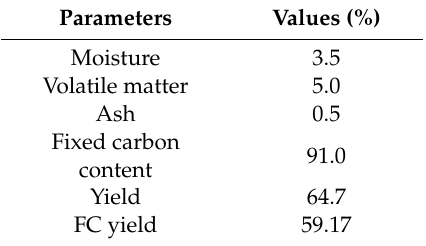
Table 4. Proximate analysis of charcoal.